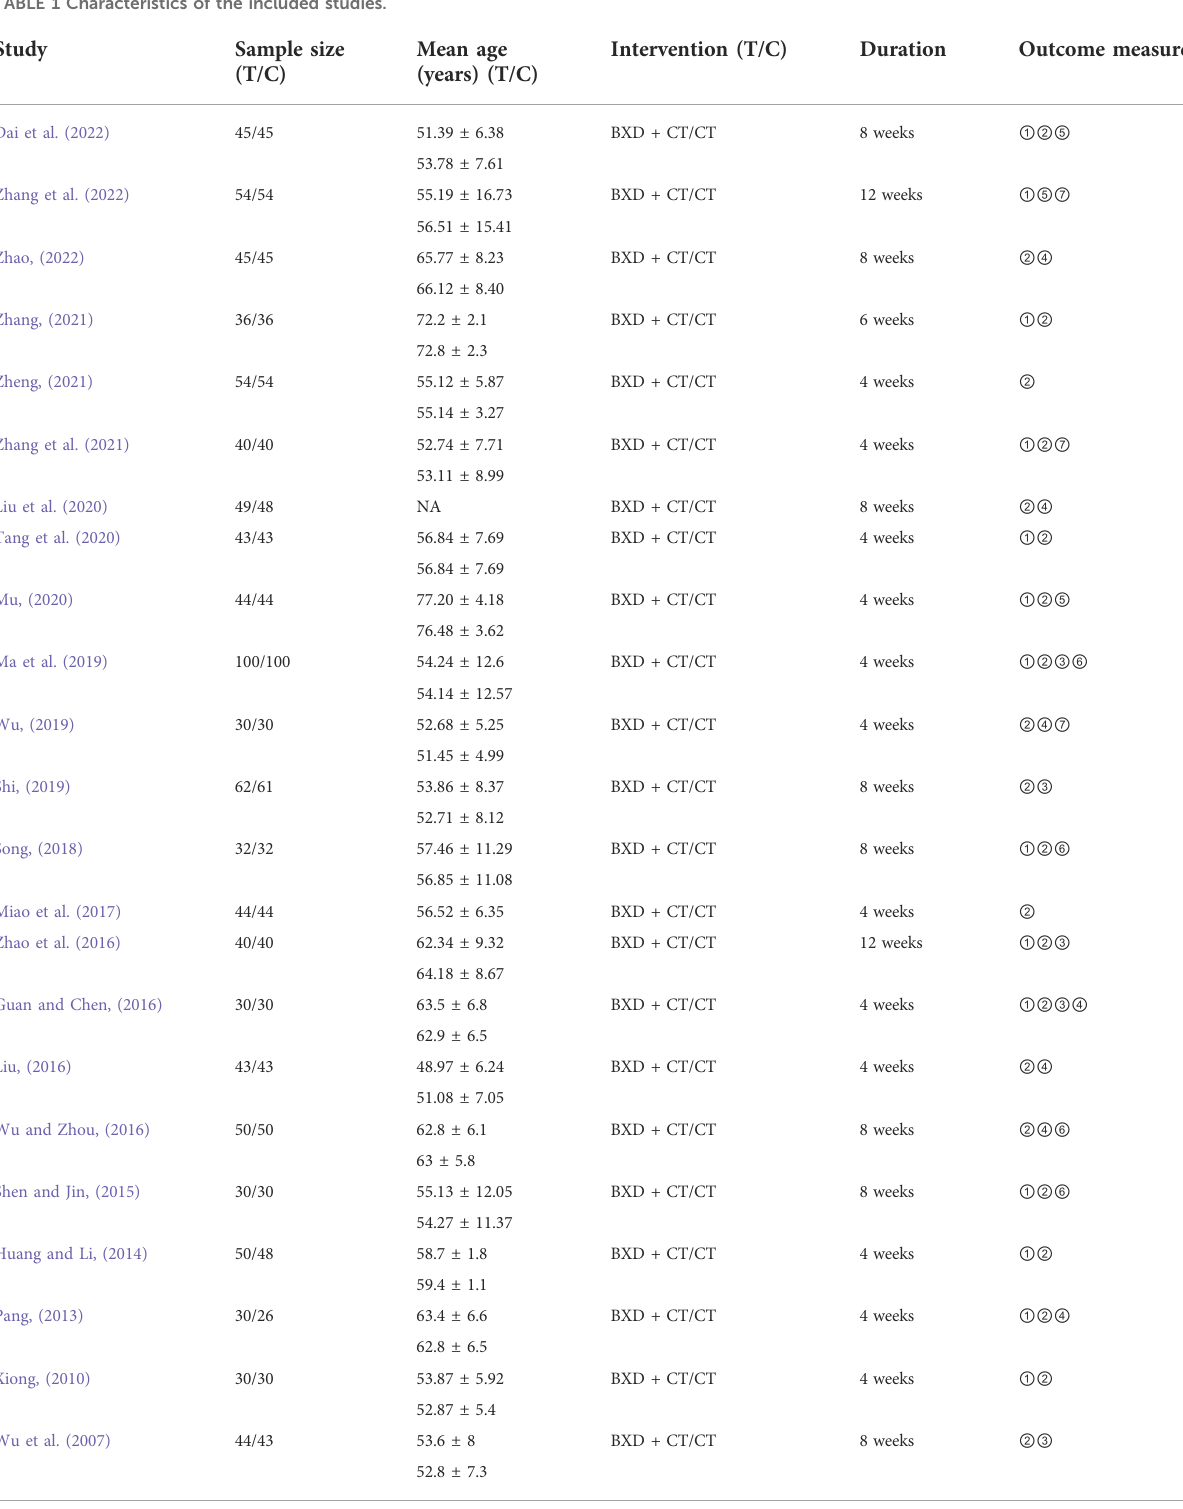
TABLE 1 Characteristics of the included